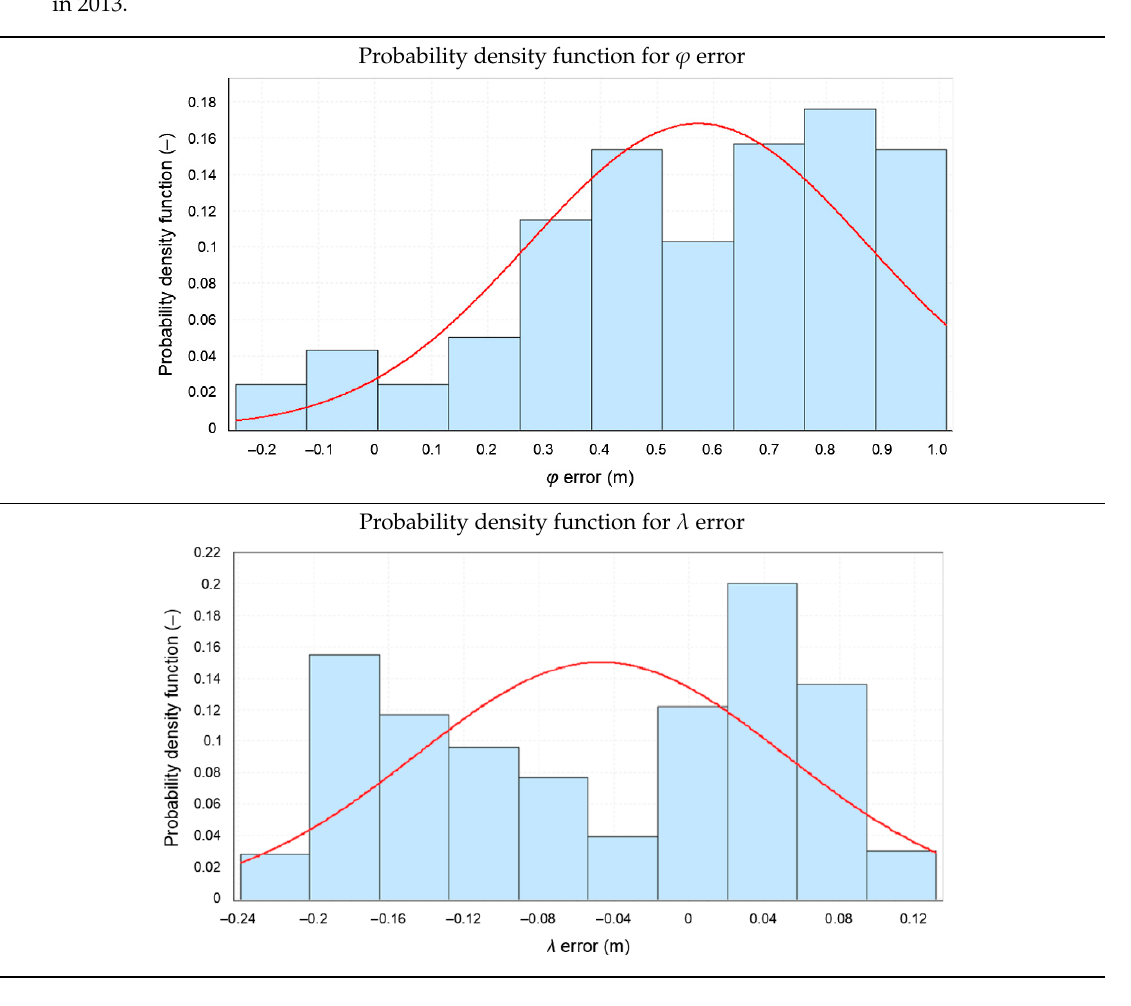
Table 5. Statistical analysis of φ and λ for the GPS session no. 1 during the measurement campaign in 2013.